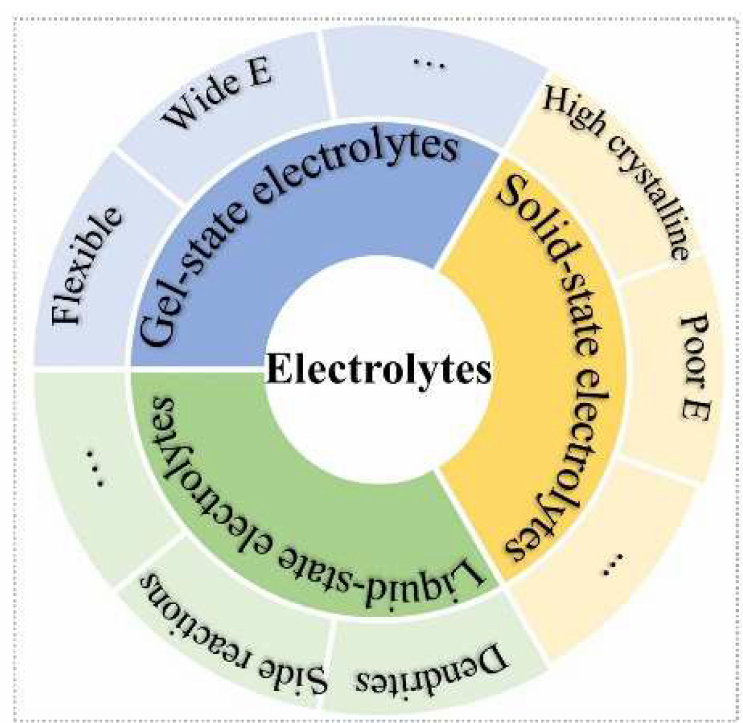
Figure 1. Schematic illustration of three types of